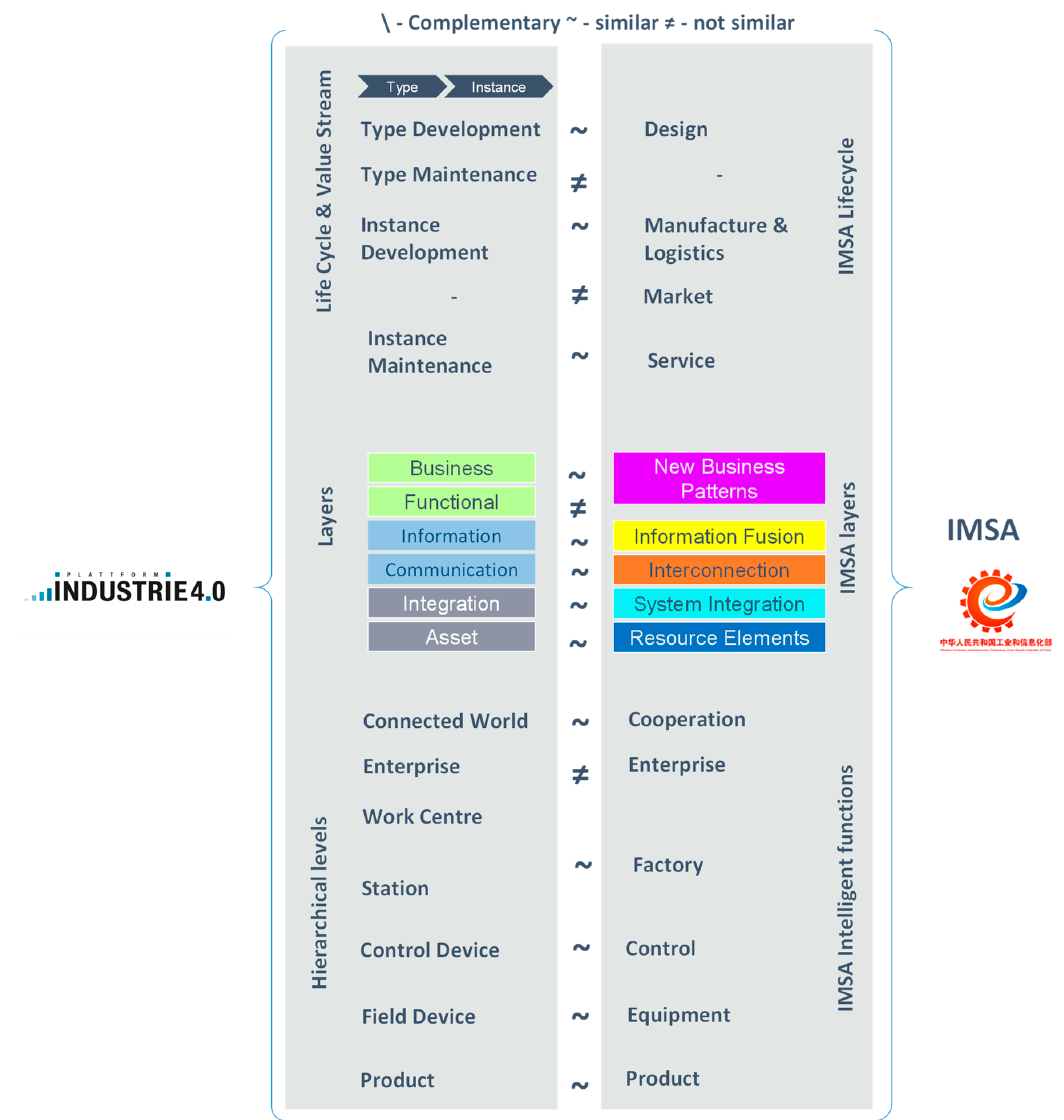
Figure 5. Alignment of RAMI 4.0 and Smart Manufacturing Standardization.